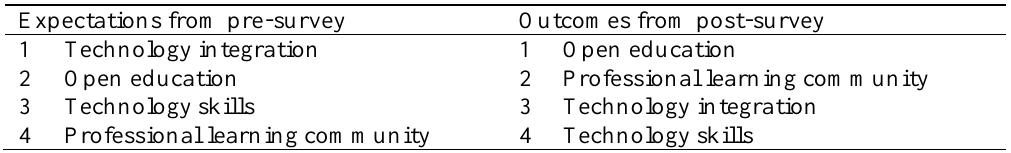
Expectations and Outcomes in Ranked